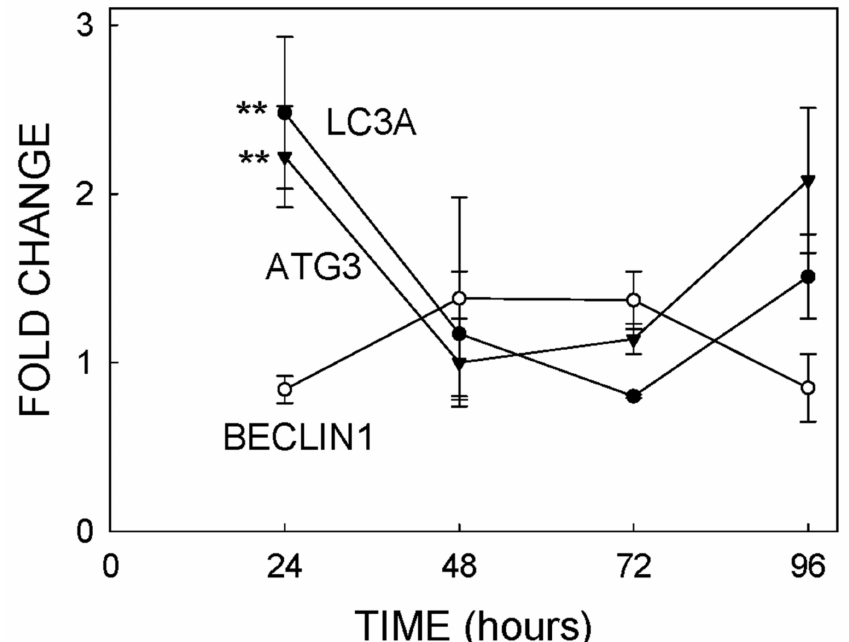
Figure 6. Expression of three different genes involved in cellular autophagy. Cells were exposed to 20 µ g/mL of TiO 2 -NPs, and the mRNA levels of three genes were determined by PCR, as de- scribed in Section 4.11. Each experimental condition was assayed with three biological replicates. ** = expression statistically differed from the control for p < 0.01. Microtubule-associated protein 1 light chain 3 alpha = LC3A and autophagy-related 3 =